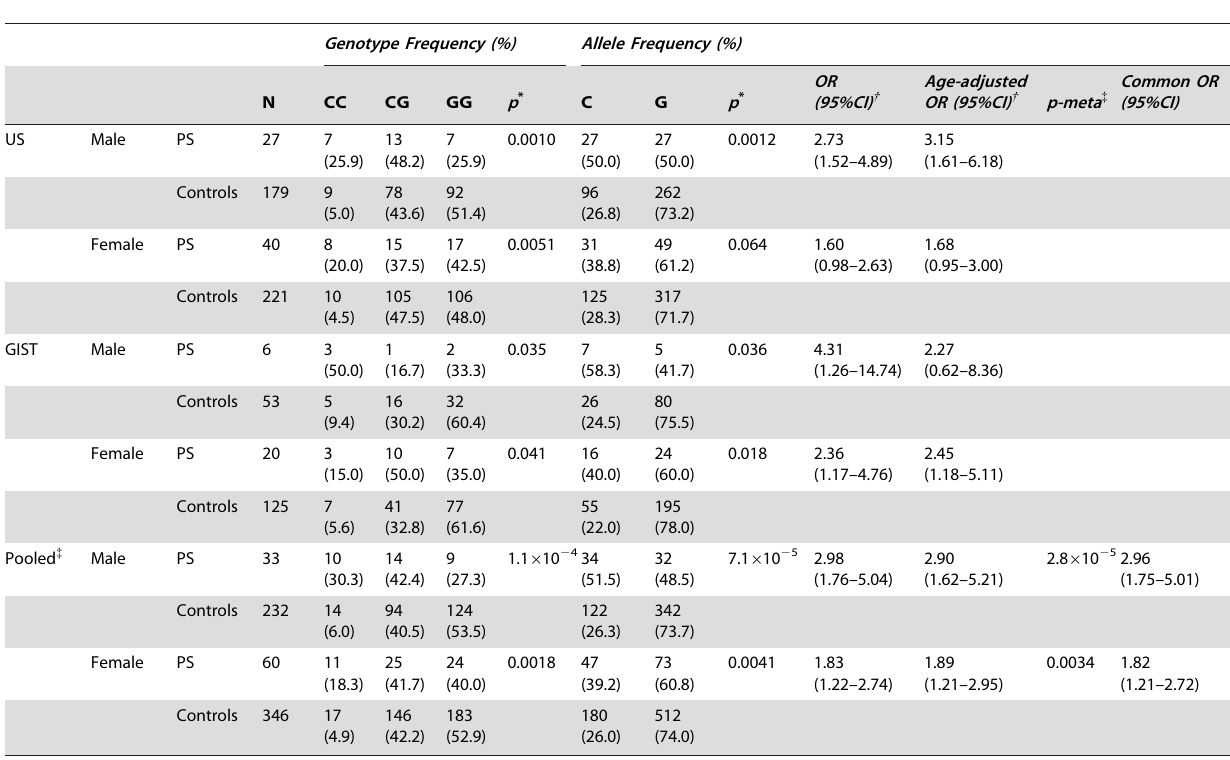
Table 4. Association of p53 codon 72 variants with paracentral scotomas (PS) in the US and GIST cohorts stratified by gender.